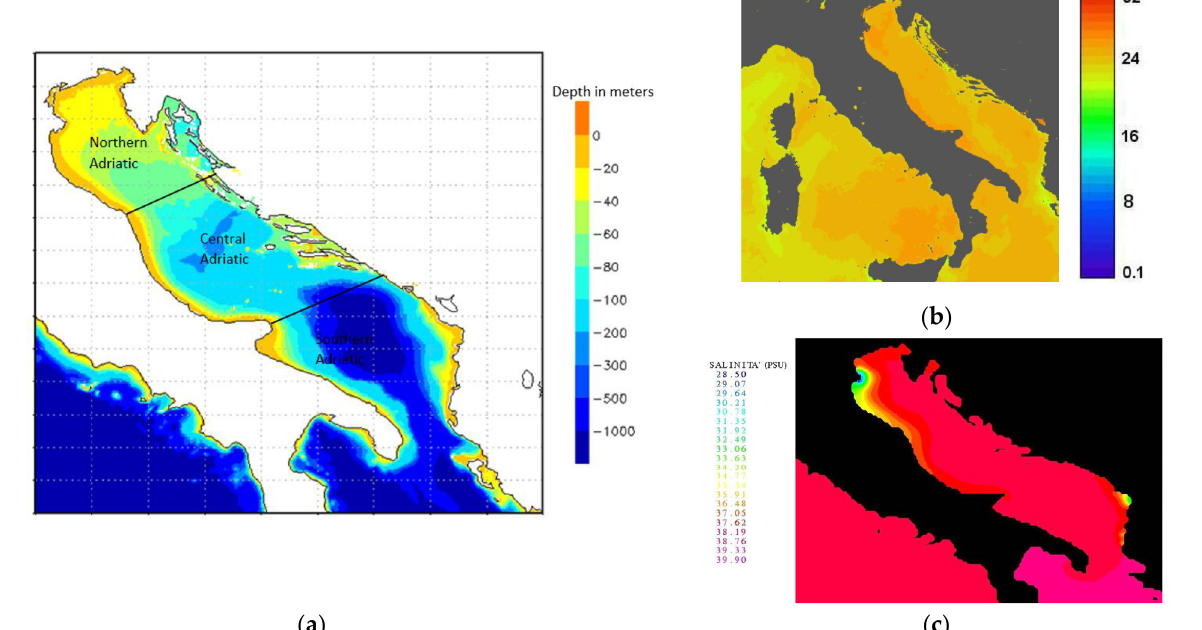
Figure 5. Characterization maps of the Adriatic Sea: ( a ) depth map, [43–45]; ( b ) water temperature distribution ( c ) water salinity distribution.